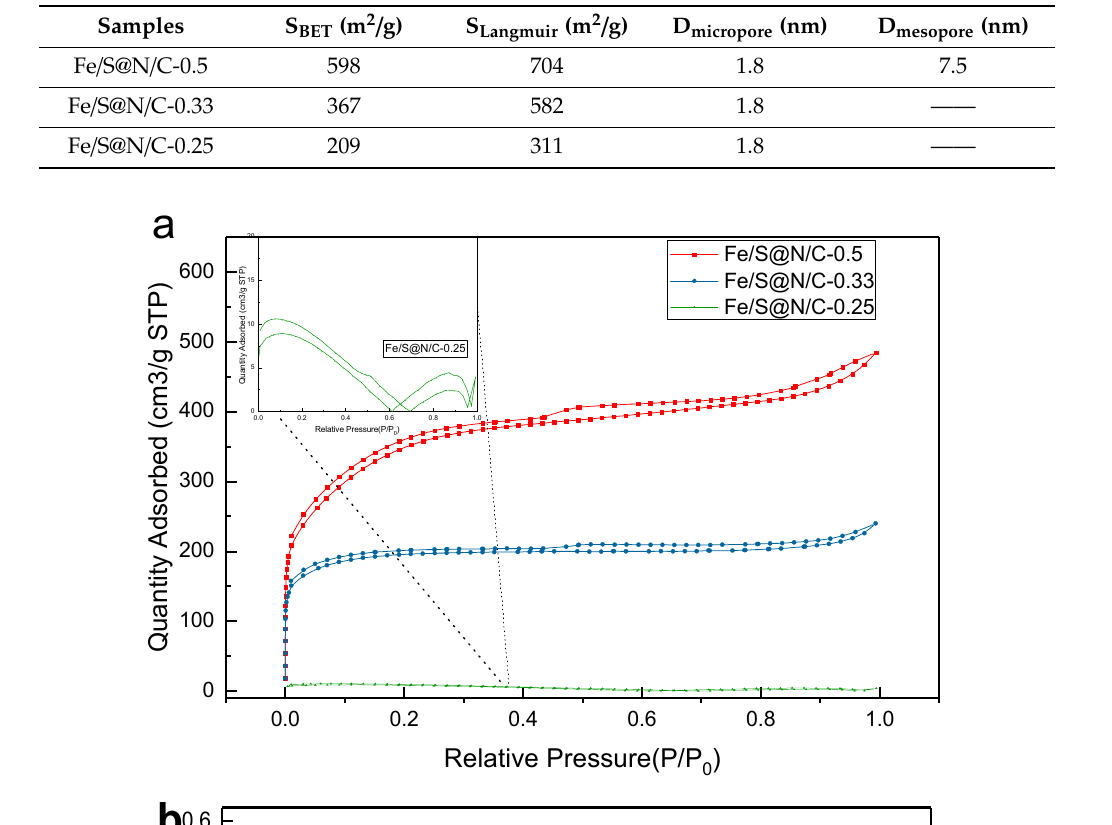
Table 5. BET and Langmuir surface area and pore diameter of Fe / S@N / C-x.